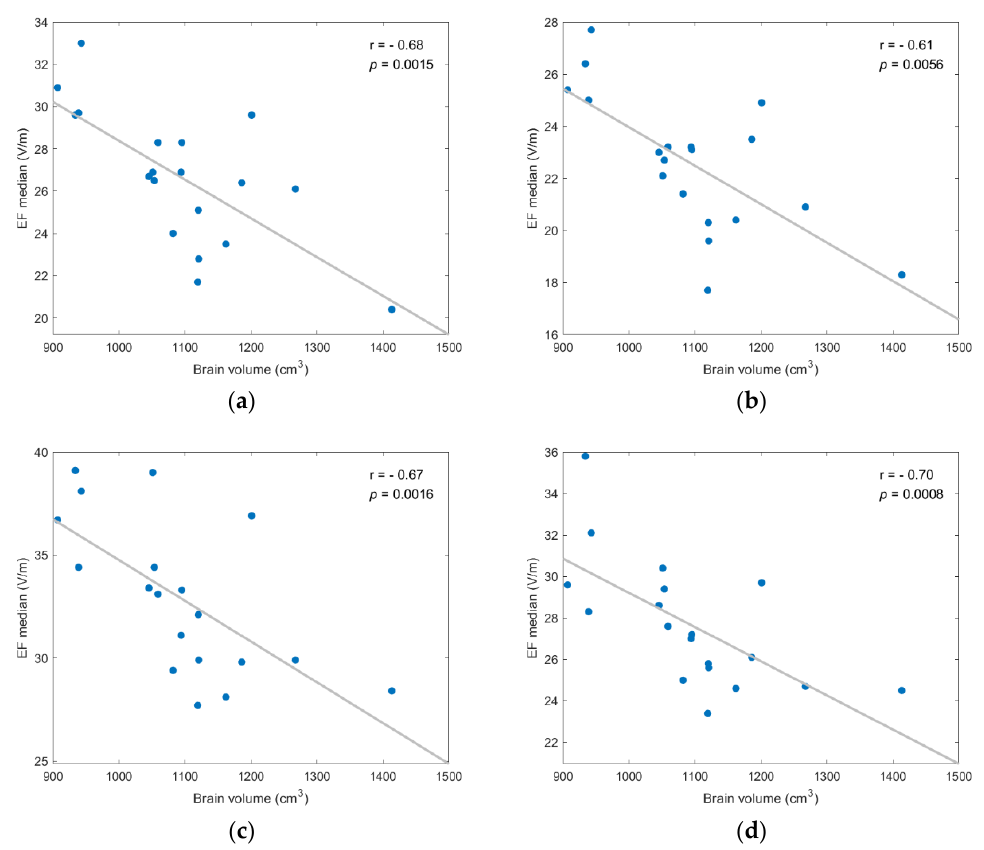
Figure 5. EF median showed statistically significant negative correlation to brain volume for each investigated scenario; ( a ) frontal coil position on anatomical models; ( b ) frontal coil position on homogeneous models; ( c ) central coil position on anatomical models; ( d ) central coil position on homogeneous models.